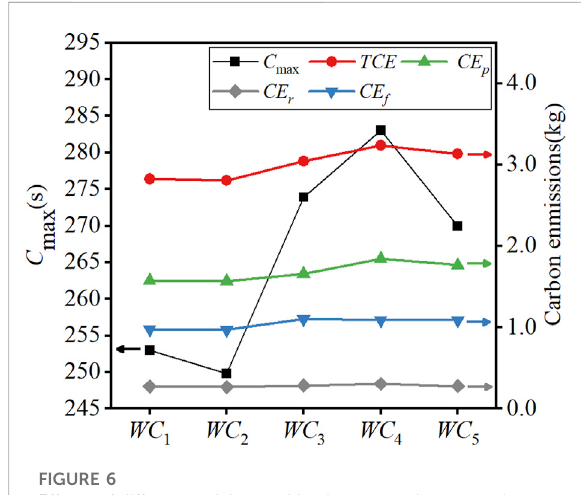
FIGURE 6 Effects of different weight combinations on makespan and carbon